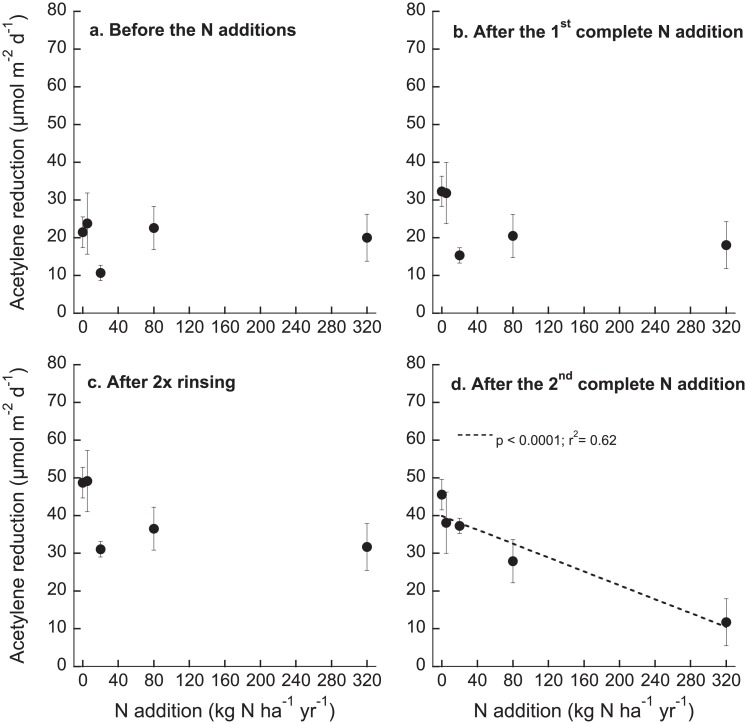
Acetylene reduction (μmol m-2 d-1) in moss samples exposed to five different N application rates (0, 5, 20, 80, 320 kg N ha-1 yr-1) at selected times during the experiment.a before the N additions started, b immediately after the 1st full addition cycle (see also week 4 in Fig 2), c after 2 weeks of rinsing with N-free water (week 6 in Fig 2) and d immediately after the 2nd full N addition cycle (week 10 in Fig 2). Given are means ± SE (n = 5). Regression lines are included if significant.